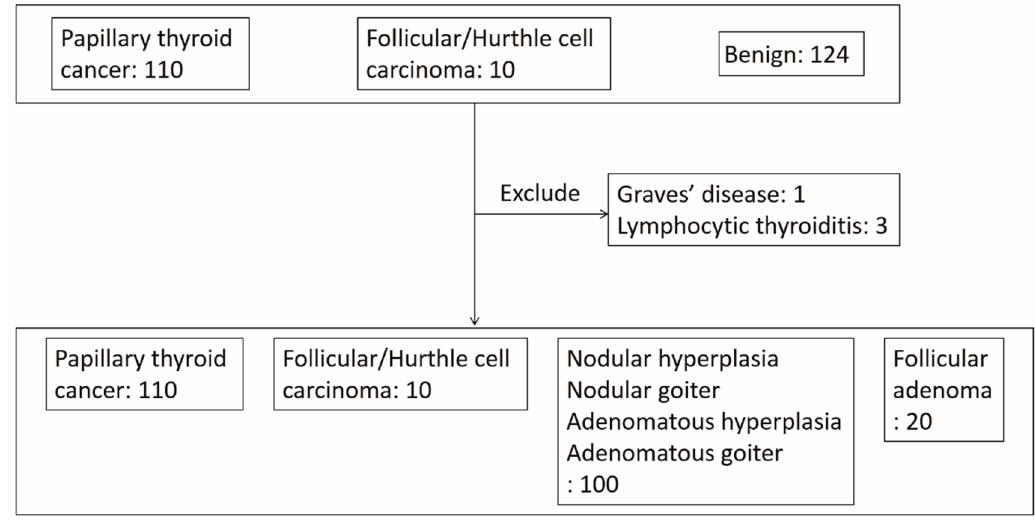
Figure 3. Flowchart of subject recruitment.